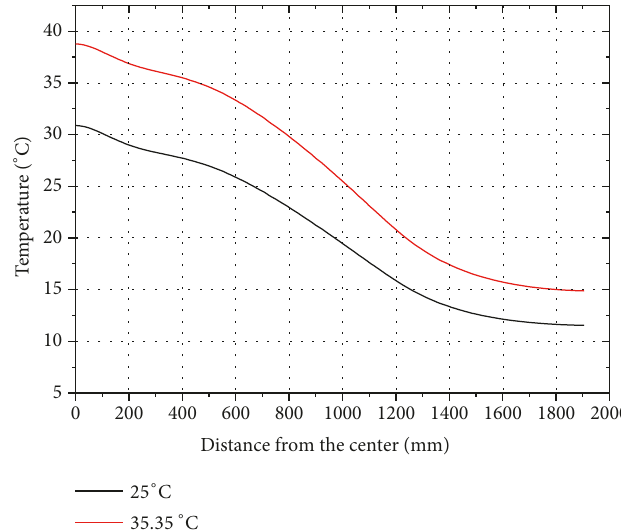
Figure 18: The temperature contrast of support bottom between Test B1 and